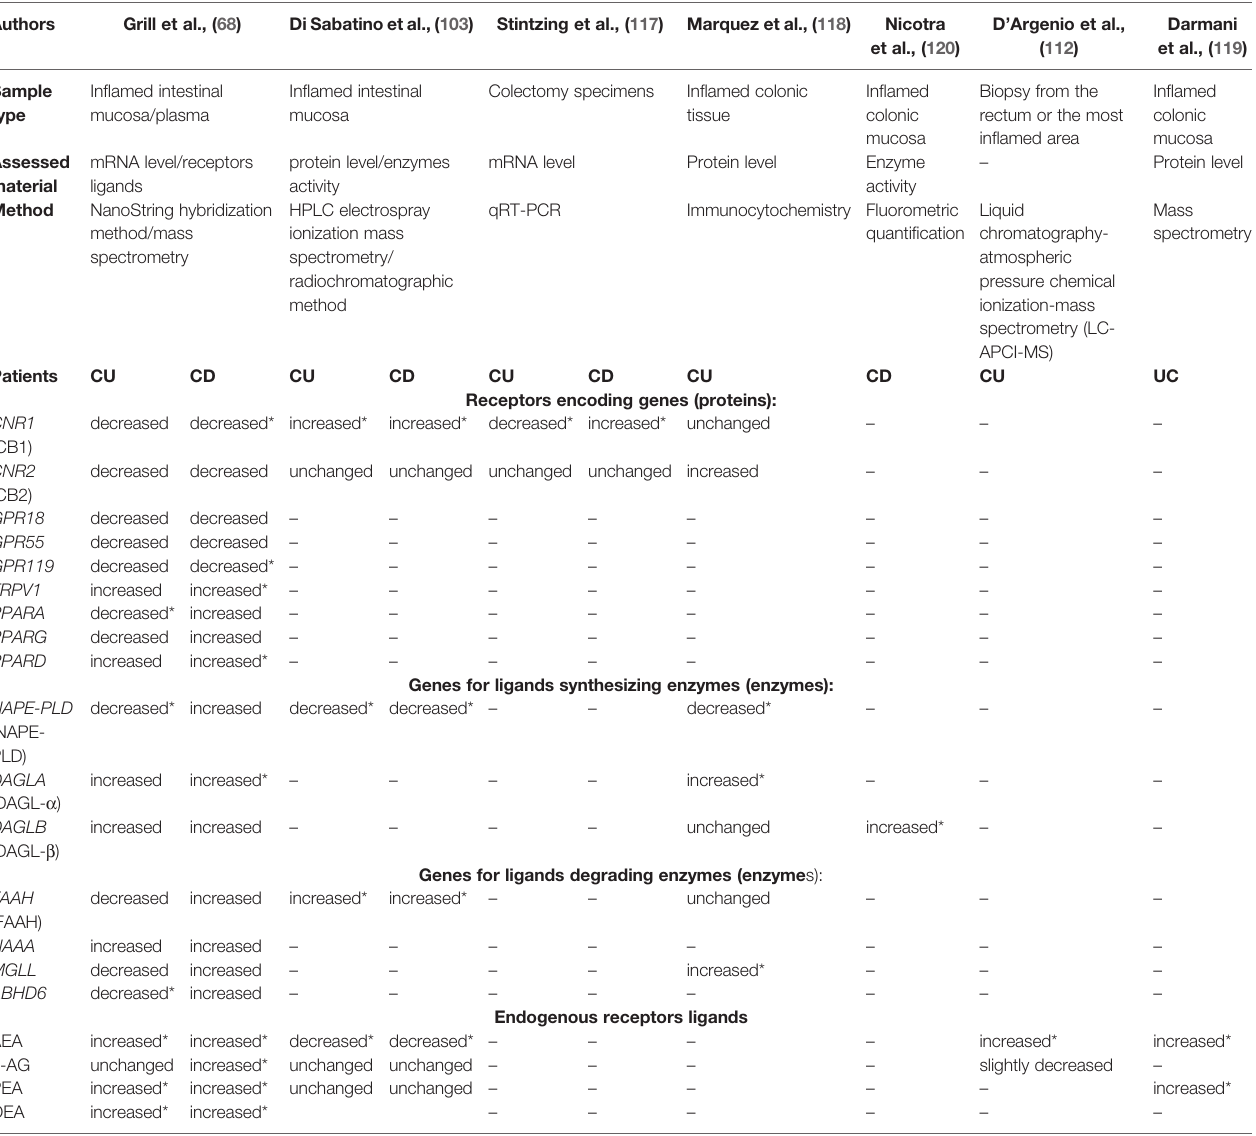
TABLE 1 | The expression data for genes coding ECS proteins and the measured levels of various ECS